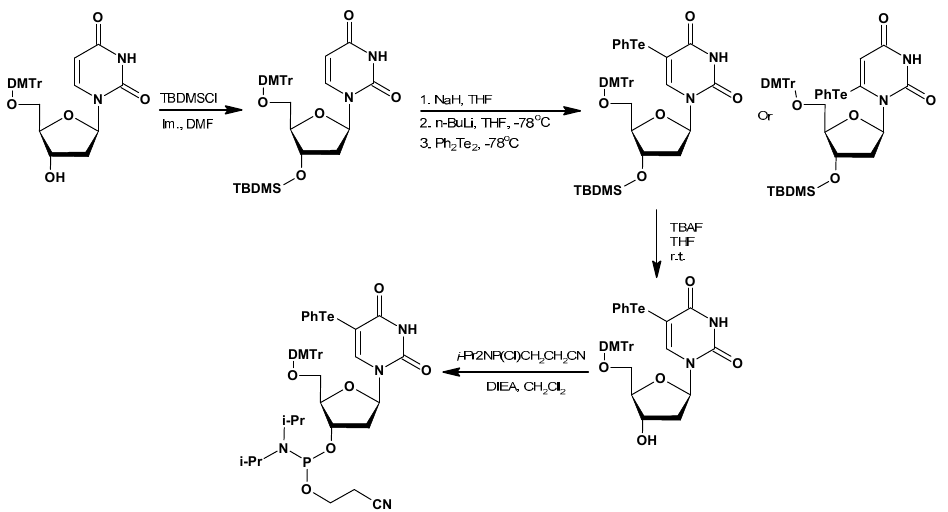
Scheme 5. Synthesis of 5-phenyltelluro-2 ′ -deoxyuridine.